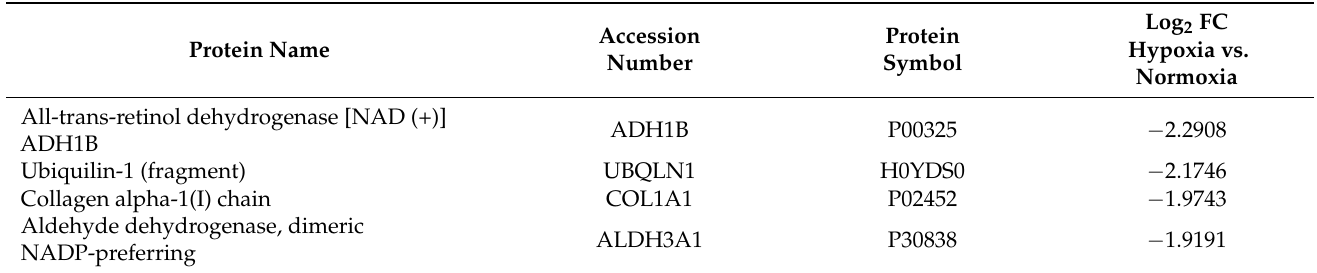
Table 3. Data on relative protein expression downregulation in hFPTs cultured in hypoxia conditions as compared to hFPTs cultured in normoxia conditions. Relative quantitative data were expressed as fold change logarithms (i.e., base 2 log) with a significance threshold value specified at − 0.9 for downregulation and an FDR threshold value specified at ≤ 0.01. Data were ranked according to their respective log 2 FC values. Full datasets are available in Supplementary